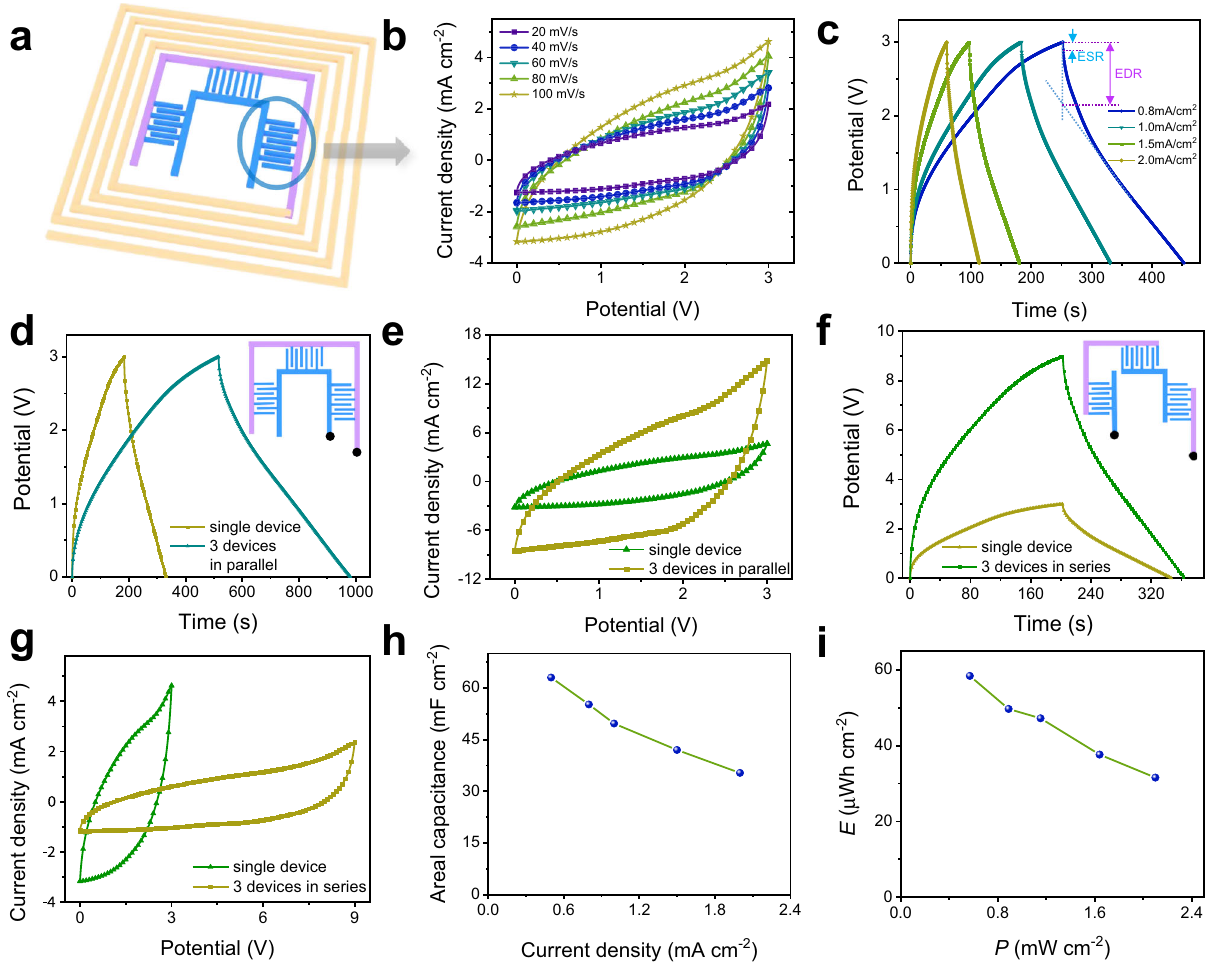
Fig. 2 Electrochemical properties of a single MSC in the integrated device. a The scheme of one MSC in the integrated device. b CV curves measured at scan rates of 20 – 100 mV s − 1 . c The galvanostatic charging/discharging curves of a single MSC with different current densities. d Galvanostatic charging/ discharging curves of a group of three MSCs connected in parallel. The inset is the schematic diagram of parallel connecting details, where black dots are testing points. e CV curves of MSCs connected in parallel. f Galvanostatic charging/discharging curves of a group of three MSCs connected in series. The inset is the schematic diagram of serial connecting details, and the black dots are testing points. g CV curves of MSCs connected in series. h The speci fi c capacitance of a single MSC calculated from the discharging time under different currents. i Power and energy densities of a single MSC unit. E and P represent energy density and power density,